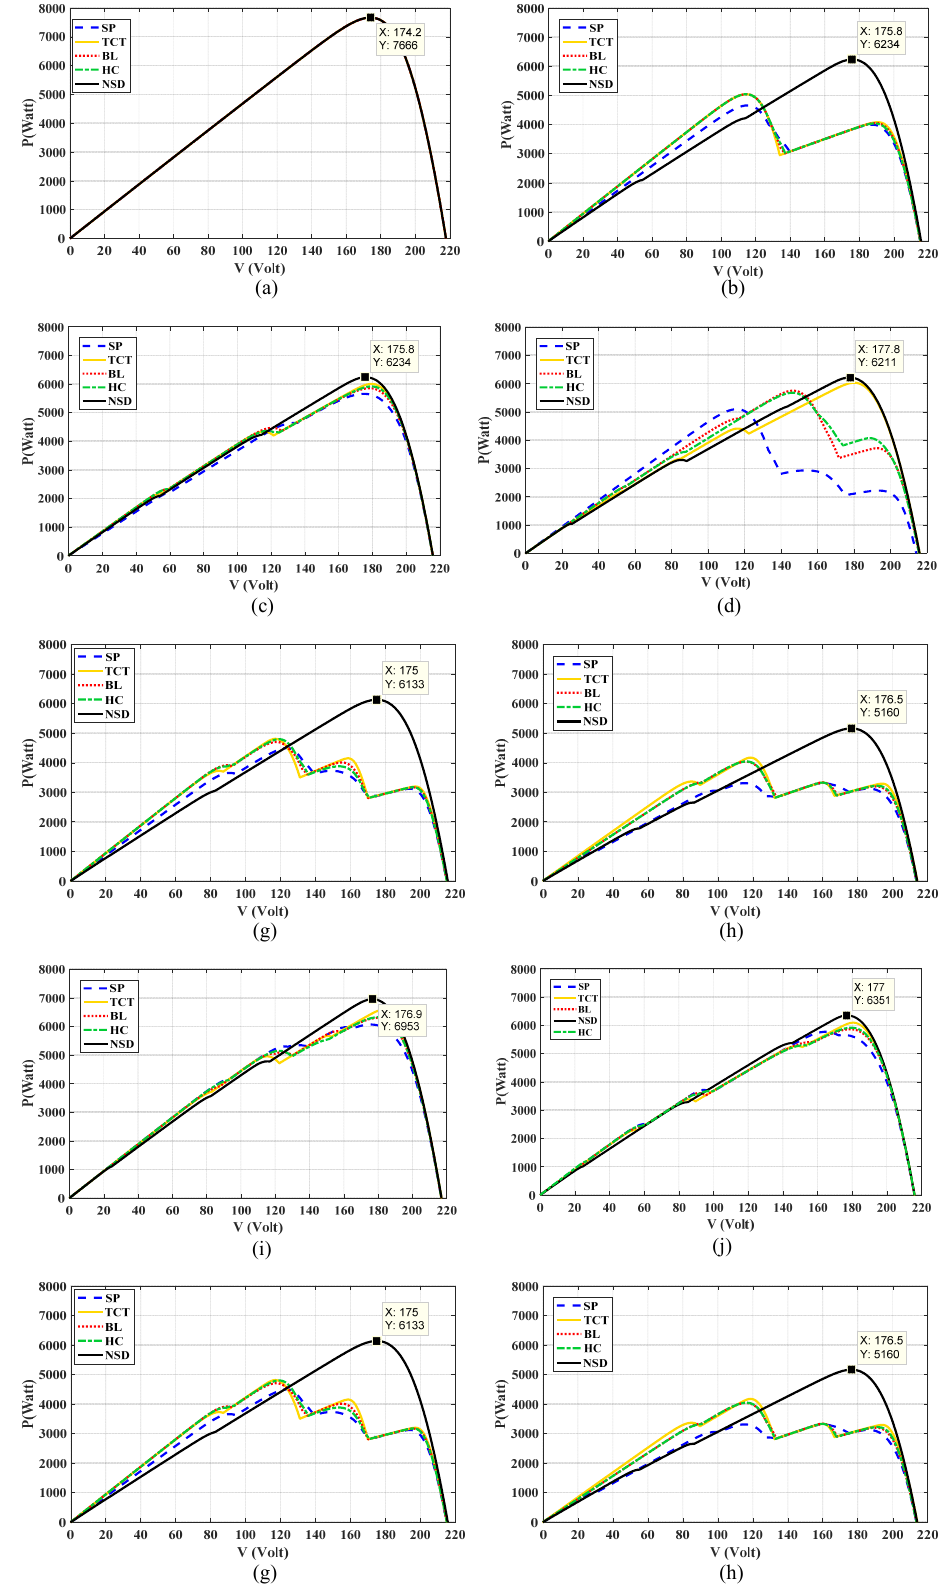
Figure 7. PV curves under various irradiance levels ( a ) case I, ( b ) case II, ( c )case III, ( d ) case IV, ( e ) case V, ( f ) case VI, ( g )case VII, ( h ) case VIII, ( i ) case IX, ( j ) case X.